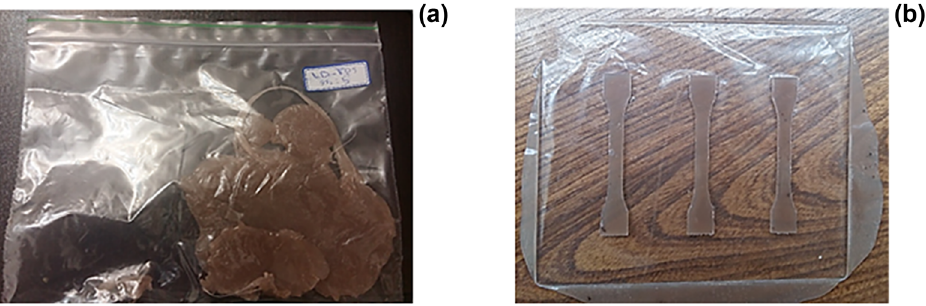
Figure 3: Polyethylene – starch – ZnO nanoparticles nanocomposite ( a ) and dumbbell shape of mixture ( b )